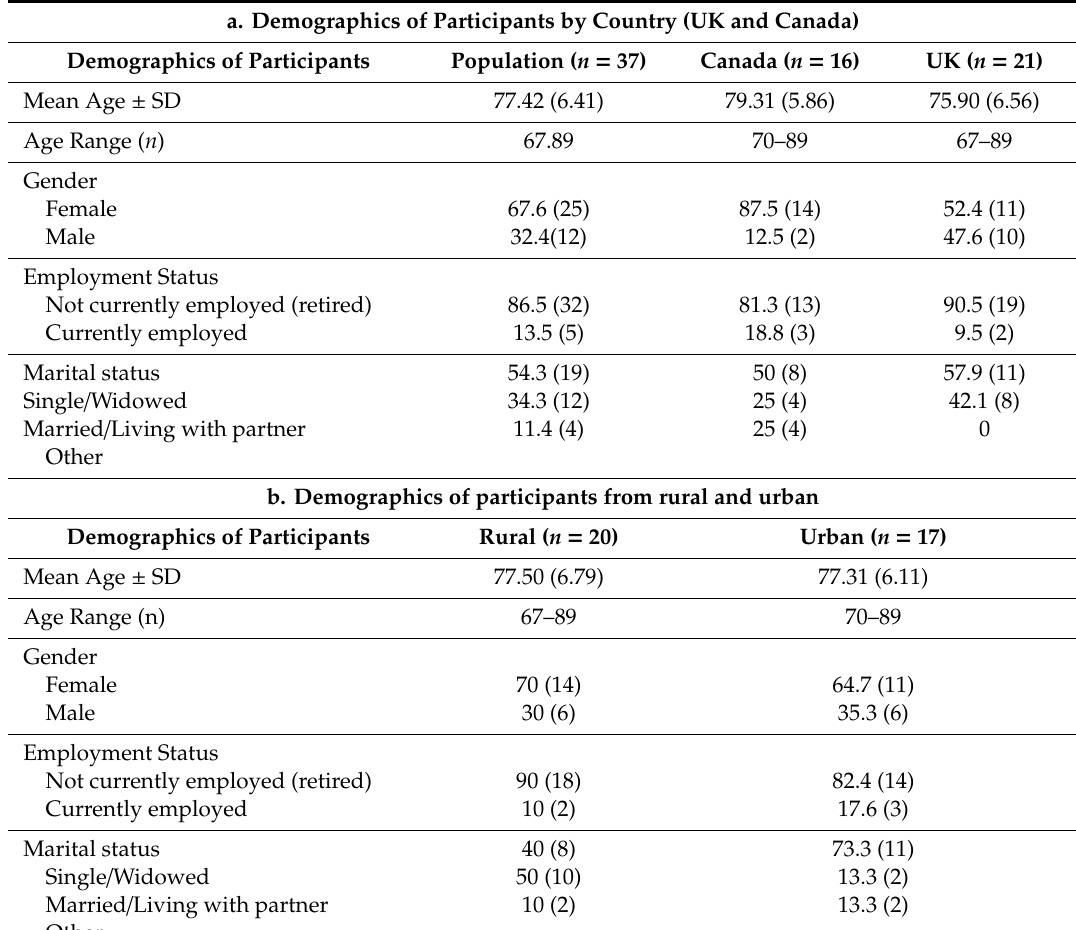
Table 1. Demographics of